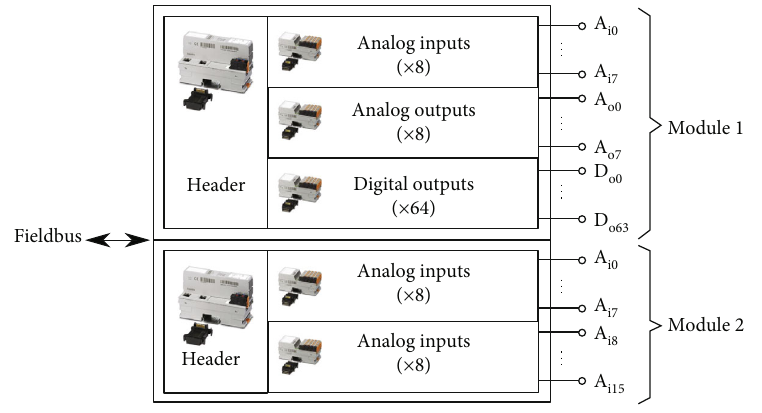
Figure 16: Example of use.